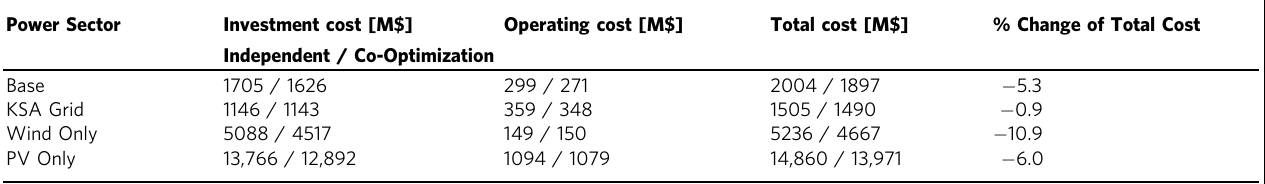
Table 1 For the power sector, all cases experience a decrease in total cost due to decreased investment spending.